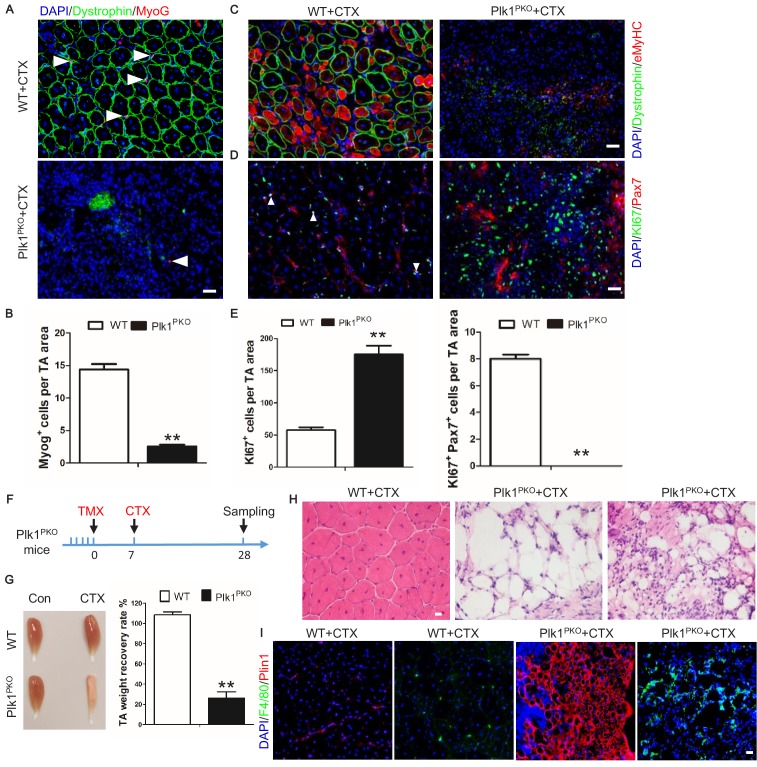
Plk1 deletion in MuSCs impairs muscle regeneration in vivo.(A) Immunofluorescence of MyoG (red) and Dystrophin (green) in TA muscle cross-sections 7 days after CTX injury, scale bar: 20 μm, white arrows point to myogenic cells; (B) The average number of MyoG+ cells per microscopic area, data represent mean ± s.e.m. (t-test: **p<0.01; n = 4 biological replicates, all MyoG+ cells from five random cross-sectional areas were counted for each mouse); (C) Immunofluorescence of eMyHC (red) and Dystrophin (green) in TA muscle cross-sections 7 days after CTX injury, scale bar: 20 μm; (D) Immunofluorescence of KI67 (green) and Pax7 (red) in TA muscle cross-sections 7 days after CTX injury, scale bar: 20 μm; (E) The average number of KI67+ cells and KI67+Pax7+ cells per microscopic area, data represent mean ± s.e.m. (t-test: **p<0.01; n = 4 biological replicates, all KI67+ cells from five random cross-sectional areas were counted for each mouse); (F) Experimental design for tamoxifen (TMX, three 3-month-old male mice in each group received a daily intraperitoneal injection for 5 consecutive days) induced deletion of Plk1 in Plk1PKO mice, following by cardiotoxin (CTX) injection to induce muscle degeneration and regeneration. Numbers indicate timing of TMX induction (following by 7 days of chasing), CTX injection and sample collection (in days, sampling at 21 days after CTX injury); (G) Representative images of TA muscles in WT and Plk1PKO mice at 21 days after CTX injury (left panel), TA muscle weight recovery at 21 days after CTX injury (right panel), data represent mean ± s.e.m. (t-test: **p<0.01; n = 3, biological replicates); (H) H and E staining of TA muscle cross-sections at 21 days after CTX injury, scale bar: 20 μm; (I) Immunofluorescence of F4/80 and Perilipin-1 (to outline adipocytes) in TA muscle cross-sections at 21 days after CTX injury, scale bar: 20 μm.